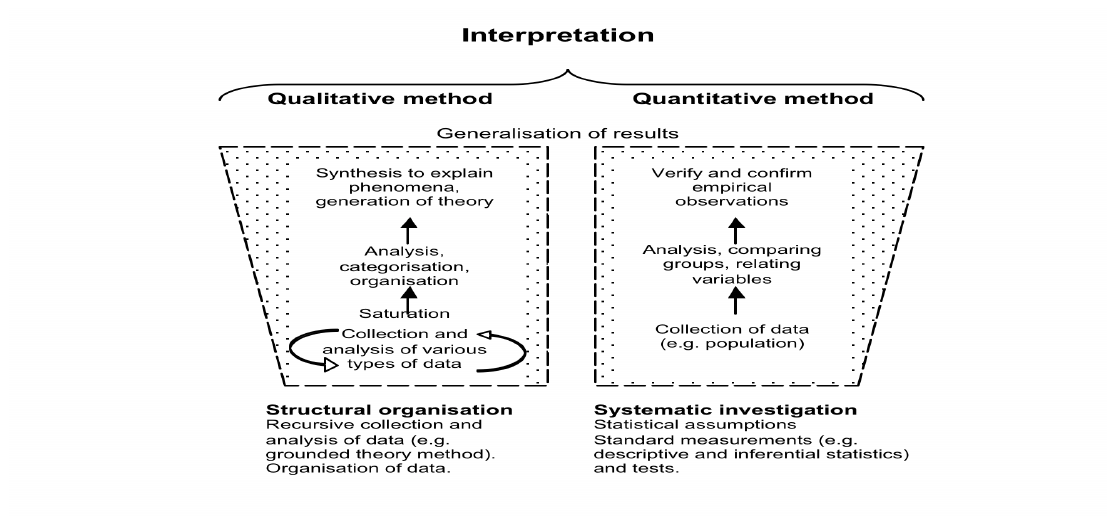
Figure 1: Application of a mixed methods